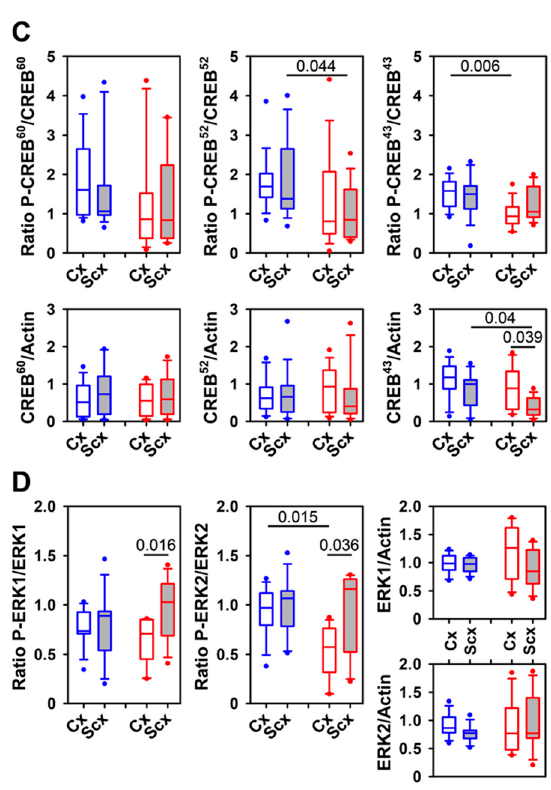
Figure 10. Activation state of downstream relaxin receptor signaling pathways. Western blot analysis was performed for cortical (Cx) and subcortical (Scx) brain vessels of control sheep (blue) and serelaxin-treated sheep (red), both not undergoing the experimental interventions. ( A ) Expression of eNOS and phospho-Ser1177-eNOS normalized to β -actin, and ratio of phospho-Ser1177-eNOS over eNOS. N = 12 (control), N = 10 (serelaxin). ( B ) Expression of long variants nNOS 161 / 165 and truncated nNOS 149 normalized to β -actin, and ratio of nNOS 149 to nNOS 161 / 165 . N = 12 (control), N = 8 (serelaxin). ( C ) Expression of CREB (cAMP-responsive element-binding protein) variants CREB 60 , CREB 52 , and CREB 43 normalized to β -actin, and ratio of phospho-Ser133-CREB variants over the respective total protein content. N = 12 (control), N = 10 (serelaxin). ( D ) Expression of ERK1 or ERK2 normalized to β -actin, and ratio of phospho-Thr202 / Tyr204-ERK-variants over the respective total protein content. N = 8 (control), N = 8 (serelaxin). For definitions of box-plots, see legend to Figure 9. Differences were identified with the Wilcoxon signed rank test for the comparison of the cortex and subcortex within a treatment group. The Mann–Whitney rank sum test was used for comparisons between groups.